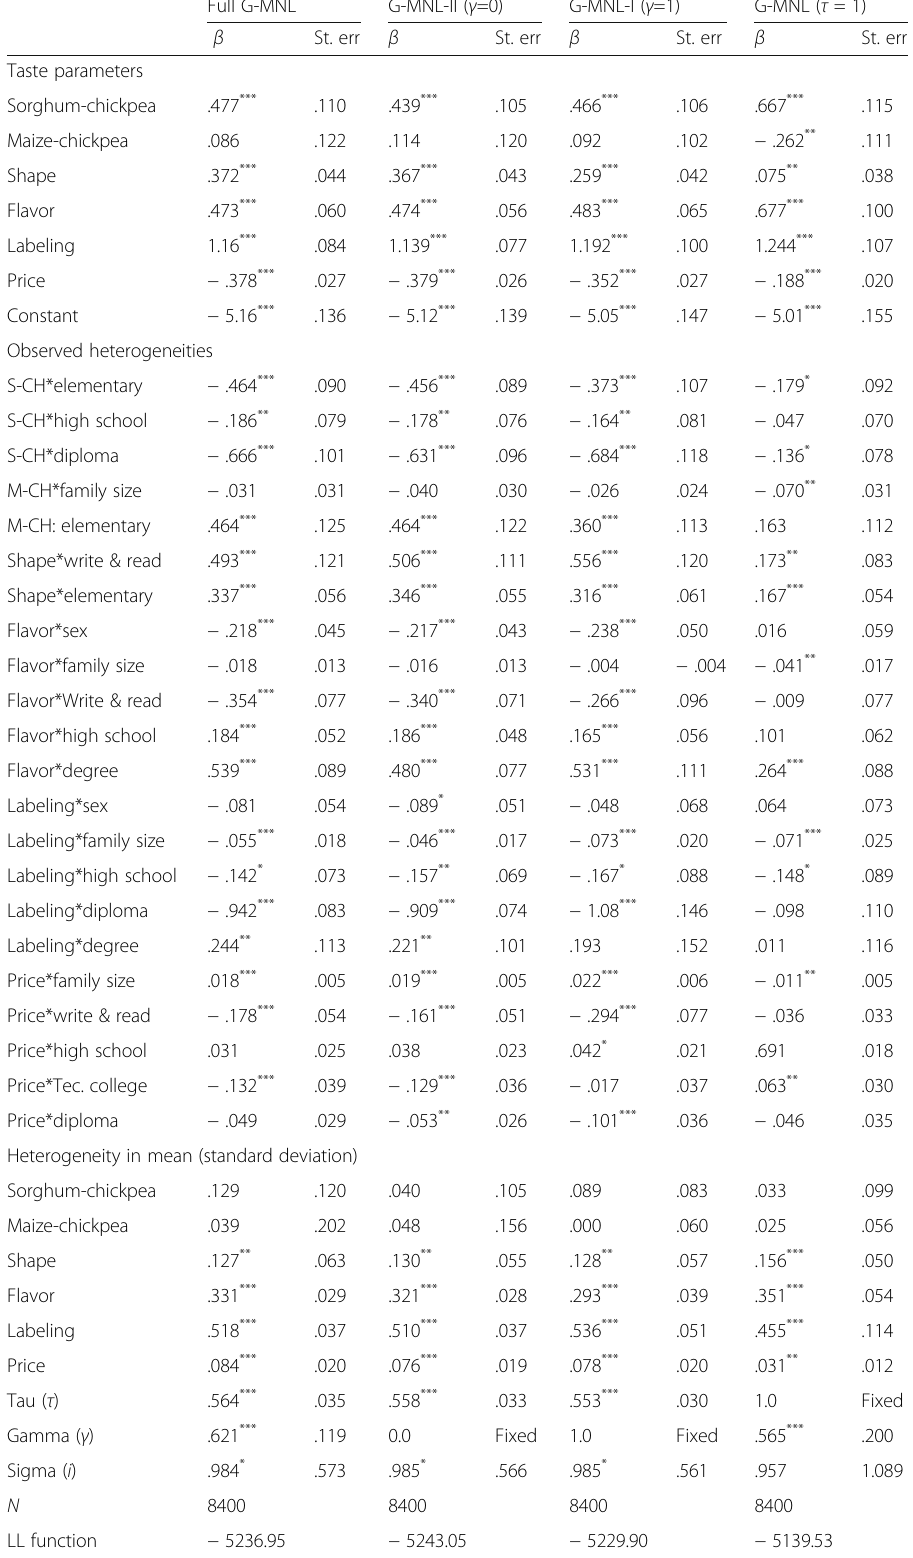
Table 6 Heterogeneity in mean taste parameter